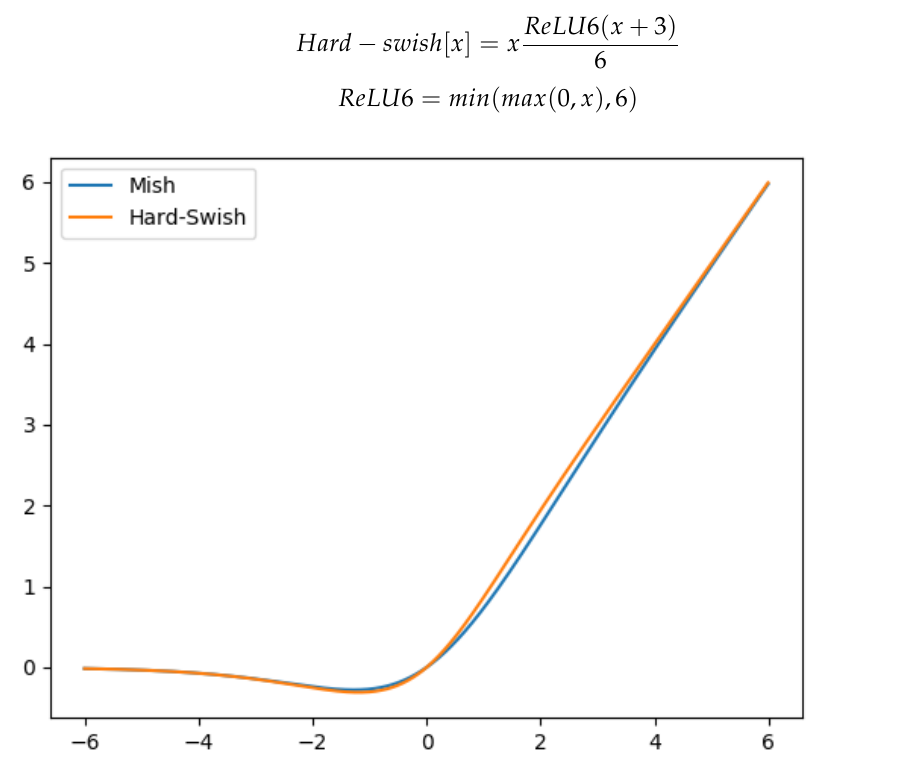
Figure 6. The comparison between the Hard-swish activation function and the Mish activation function. The overall network architecture of the SMYOLO model is shown in Figure 7, where Convolution represents conventional Convolution, Conv 1 × 1 represents point convolution, and Depthwise Conv represents depth separable Convolution. More profound network architecture can obtain higher accuracy. In contrast, a narrower network architecture limits the complexity of the network. Due to the limited computing power of airborne drone equipment, to limit the complexity of YOLOv4, SMYOLO uses deep separable convolution and point convolution to build the network. In the main convolution operation of the network backbone structure, by adding point convolution, the number of networks in- creases the depth of the network, thereby reducing the complexity of the model. Compared with other detection networks, SMYOLO has fewer network layers and fewer calculations, enabling it to deploy airborne drone equipment.